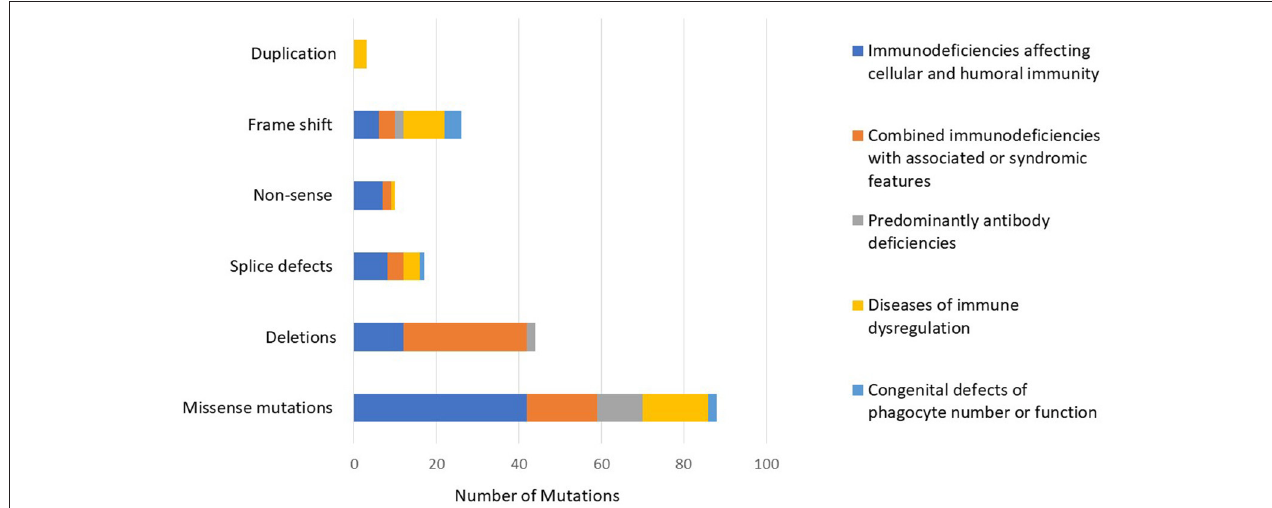
FIGURE 3 | The distribution of mutations according to the PID category showing a predominance of missense mutations followed by deletions and frame shift